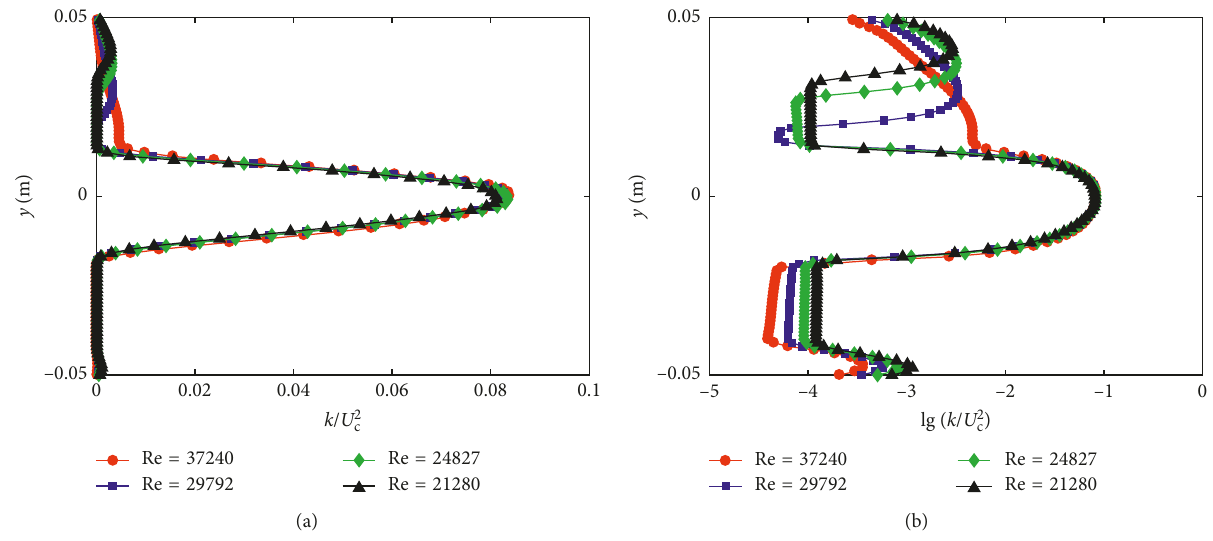
Figure 4: Normalized turbulence kinetic energy profiles on the vertical centerline at x �